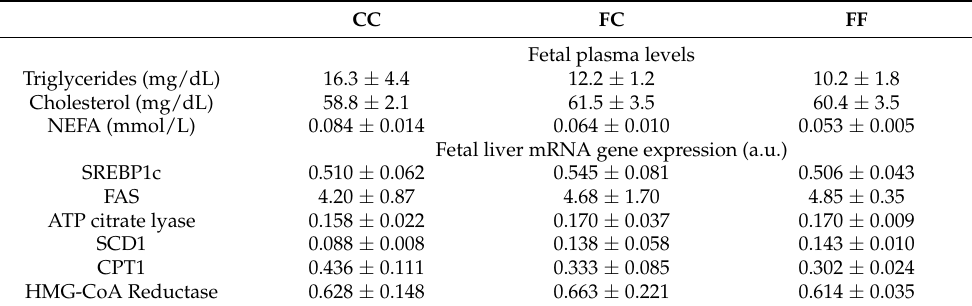
Table 3. Plasma analytes and liver gene expression in fetuses from pregnant rats from fructose-fed mothers subjected (FF) or not (FC) to fructose intake throughout pregnancy and fetuses from control mothers (CC).